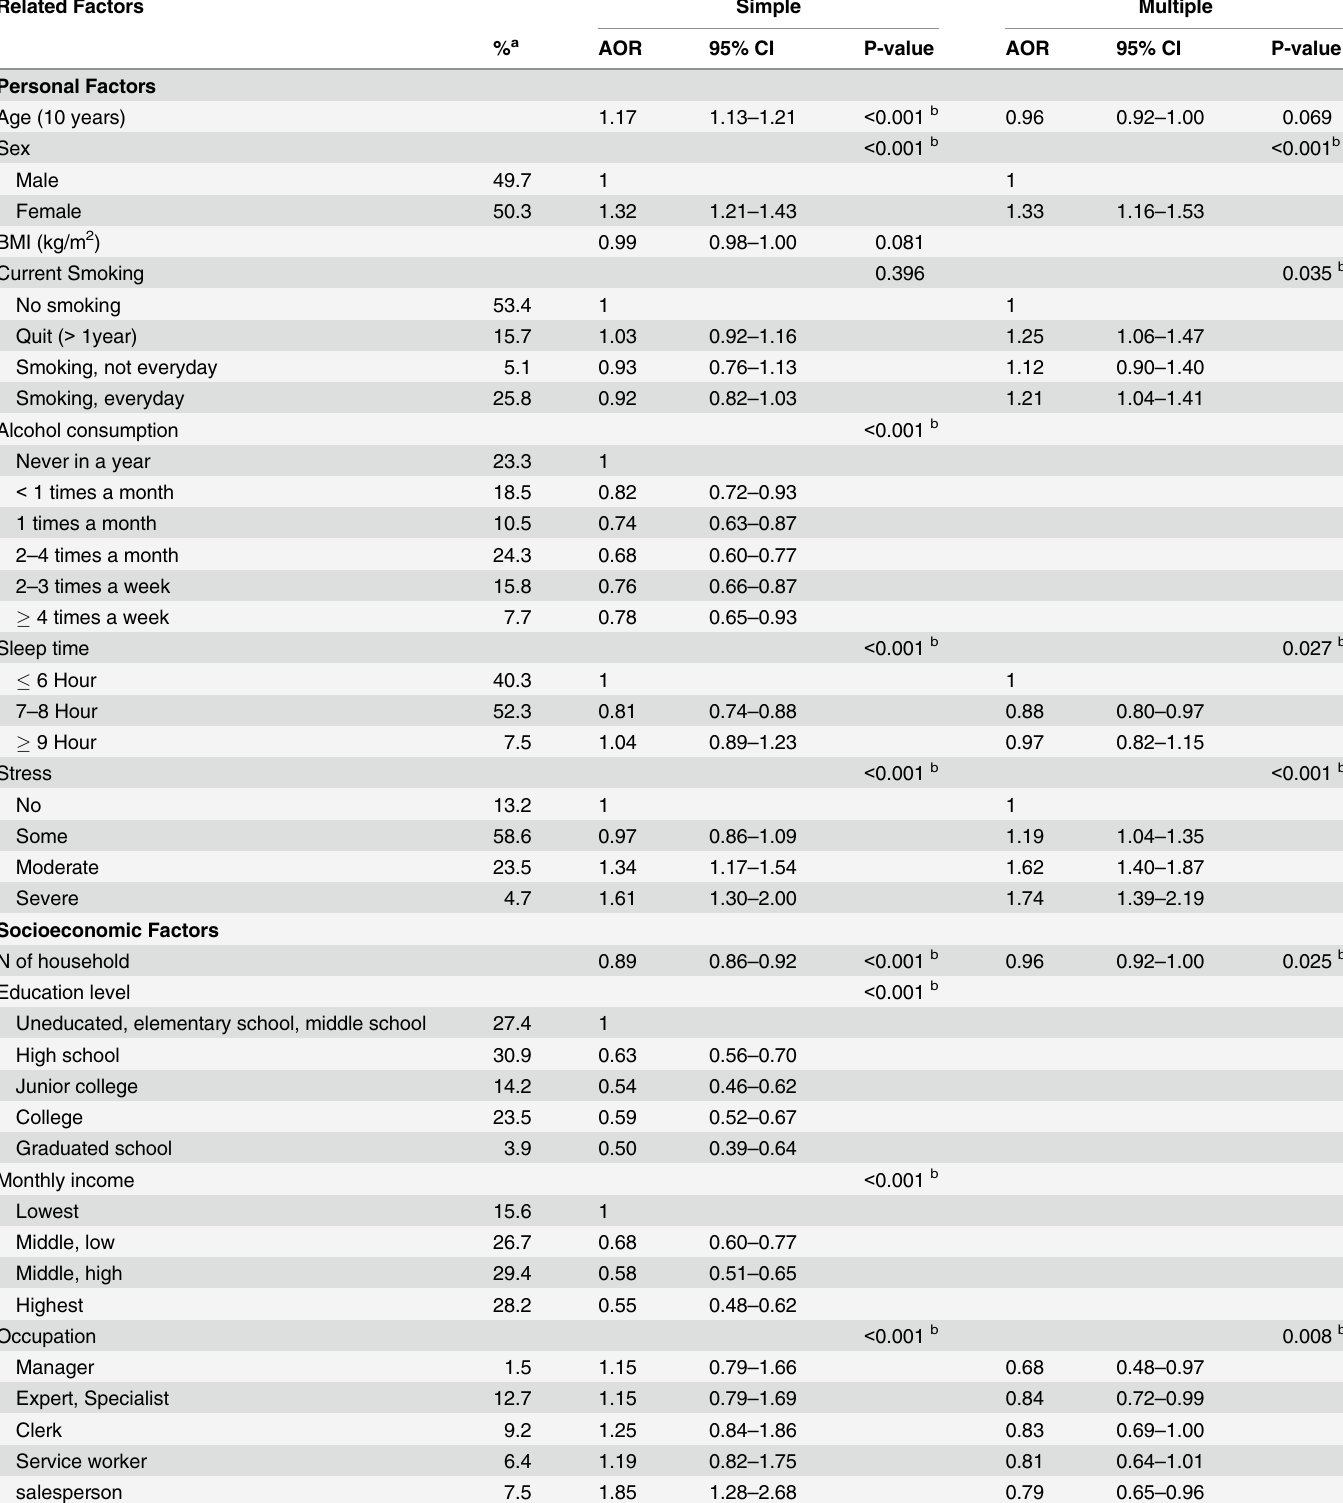
Table 2. Simple and multiple logistic regression analysis with complex sampling for